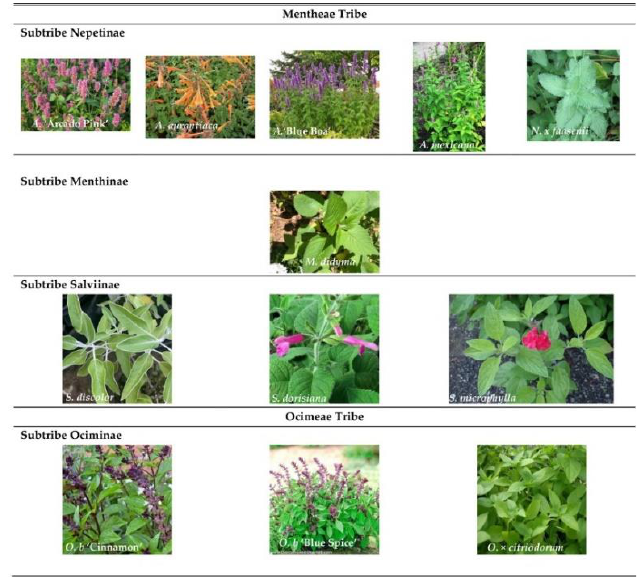
Figure 5. Selected flowers belonging to two tribe of Lamiaceae